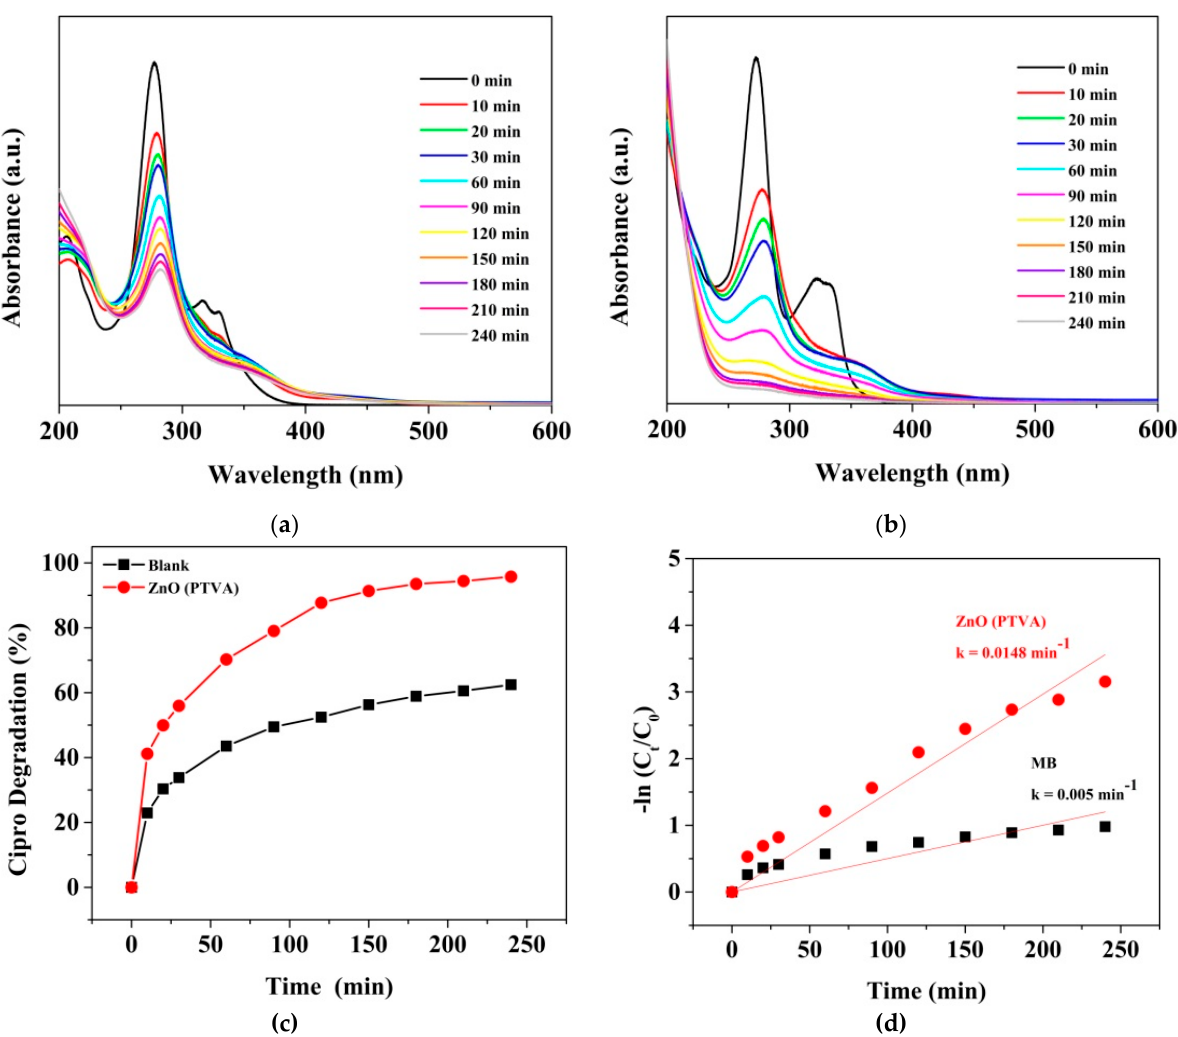
Figure 8. UV-Vis-absorption spectra of Cipro solution as a function of irradiation time acquired in the absence ( a ) and presence ( b ) of ZnO synthesized by PTVA approach. ( c ) Photocatalytic-degradation plots of Cipro in the absence or presence of nanostructured ZnO coating within 240 min of UV irradiation. ( d ) Linear kinetic-fitting curves with the degradation-rate constants for the UV-induced dissociation of Cipro.